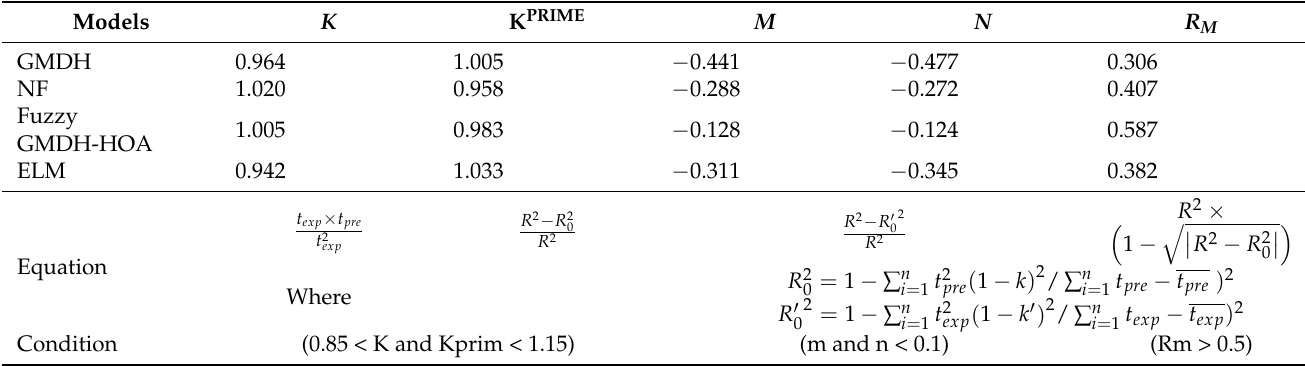
Table 5. External validation of predictive